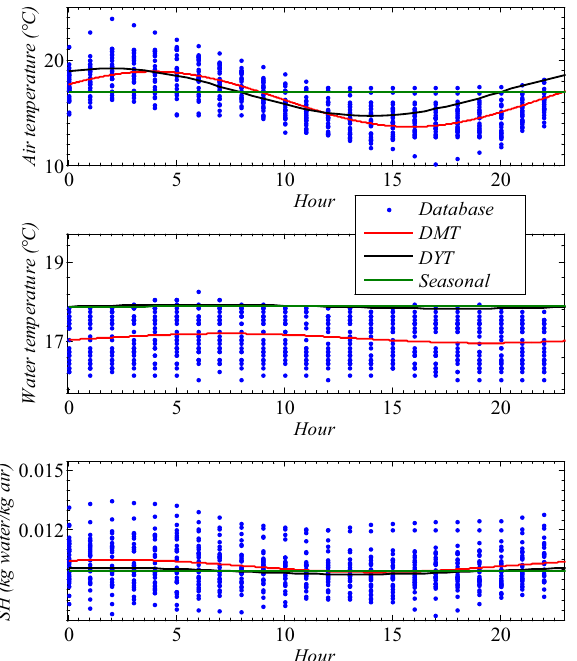
Fig. 5 Determination of the daily monthly-based model, August, 2005 in Brest,